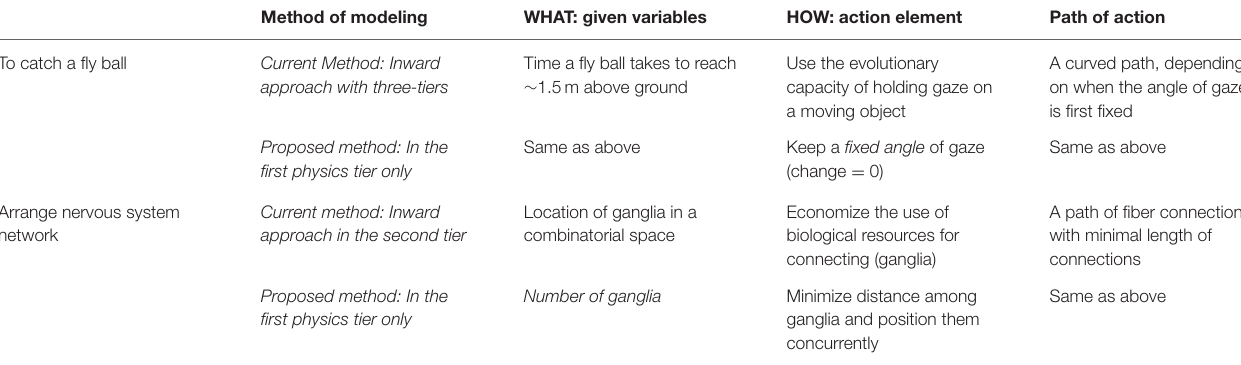
TABLE 1 | Using the principle of least action to model catching a fly ball and the nematode nervous system (Source: Mousavi and Sunder, 2021). Method of